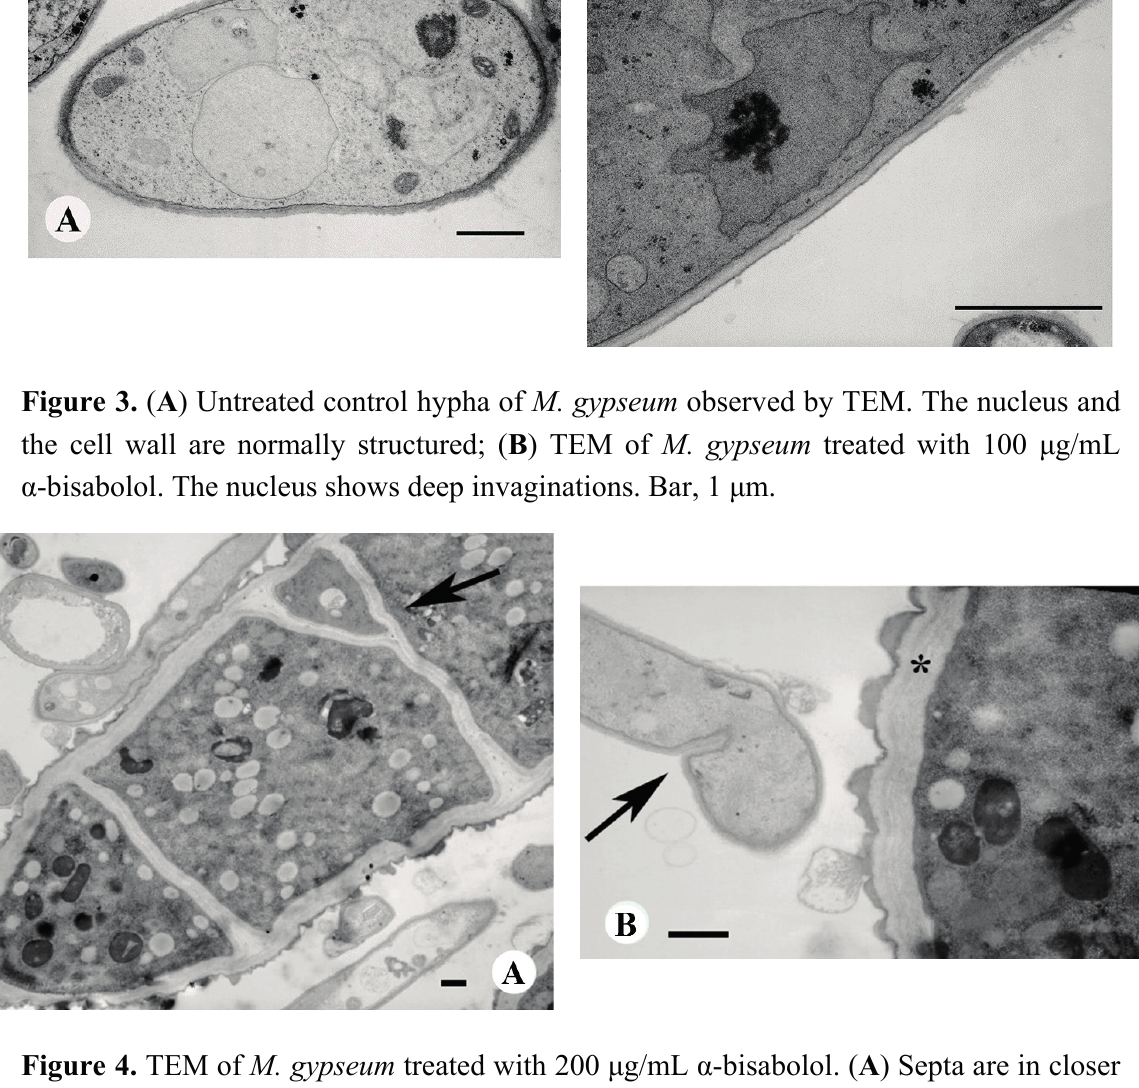
Figure 4. TEM of M. gypseum treated with 200 μ g/mL α -bisabolol. ( A ) Septa are in closer proximity with each other and have anomalous shapes; arrow indicates a bifidous septum; ( B ) Arrow indicates the early formation of a septum in the sub apical area; asterisk indicates an abnormal multilayer cell wall. Bar, 1 μ